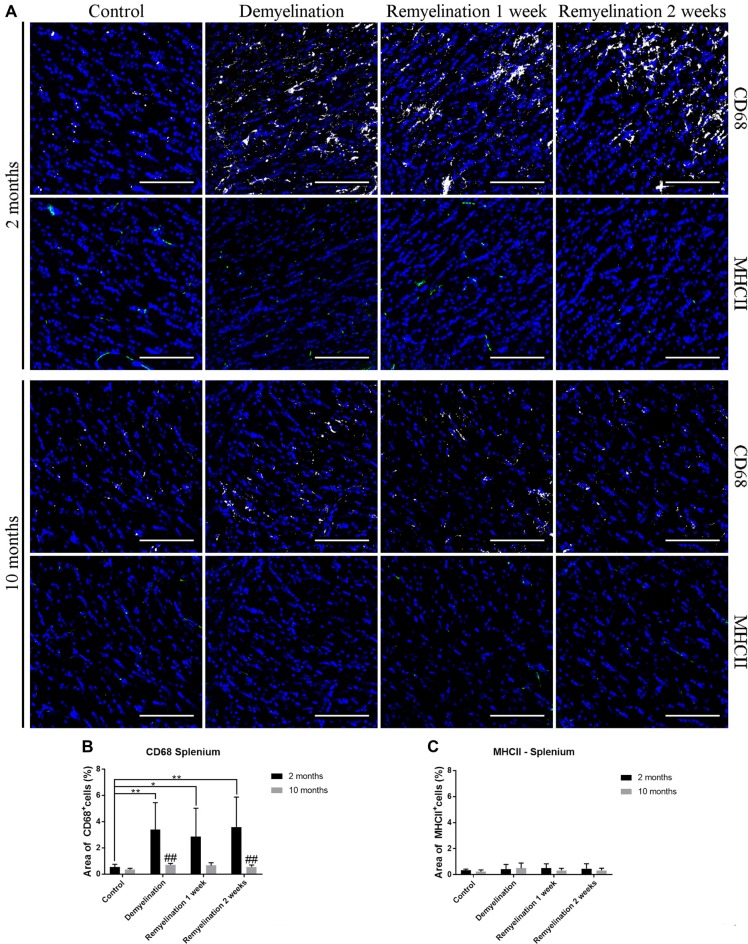
Age-related differences in CD68, but not in MHCII, in splenium of the CC. (A) CD68 (white) and MHCII (green) labeling. Cell nuclei are stained with DAPI (blue). (B) CD68 was significantly increased during de- and remyelination only in the younger group leading to significant age-related differences (with higher values in the younger group) after demyelination and 2 weeks of remyelination. (C) MHCII staining was not significantly changed by de- or remyelination in both age groups. Values are shown as means + SD (n = 6 per group). Statistical significance was evaluated using a two-way ANOVA followed by a Tukey’s post hoc test. The p-values are indicated in the graphs: treatment effects within the same age group: *p < 0.05 and **p < 0.01, age-related differences: ##p < 0.01. Bars: (A) 100 μm.